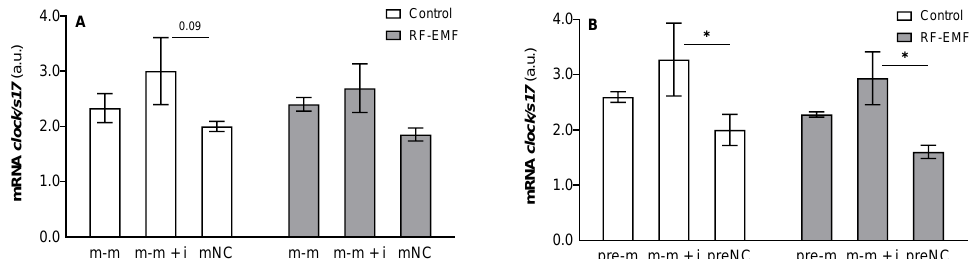
Figure 5. Effect of miR-34a administration on clock mRNA expression in DLD1 cells under control and RF-EMF conditions. Cells were transfected with ( A ) miR-34a-5p (m-m), ( B ) pre-miR-34a (pre-m), mimic of mature miR-34a together with the miR-34a inhibitor (m-m + i) or corresponding negative control of mature and pre-miRNA (mNC and preNC, respectively). The data were relativised to the corresponding negative control measured under control conditionspresented as the mean ± SEM (n = 4). a.u.—arbitrary units. Two-way ANOVA, Tukey’s post hoc test, * p < 0.05. Two-way ANOVA revealed a significant effect of miR-34a on bmal1 mRNA expression (m-m: F [2, 17] = 7.879, p < 0.01, Figure 6A; pre-m: F [2, 17] = 10.31, p < 0.01, Figure 6B), and a